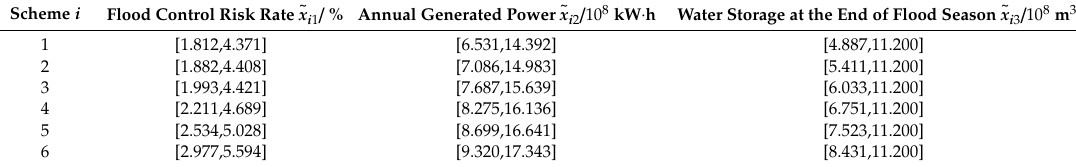
Table 4. Initial interval number decision matrix (cid:101) X .